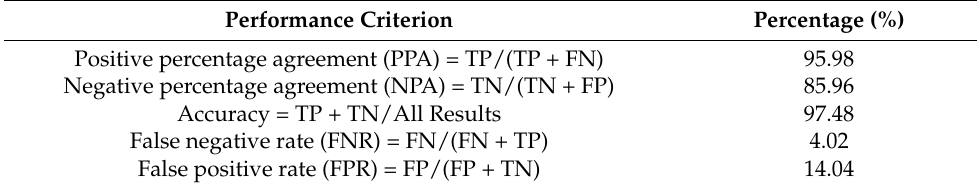
Table 2. Performance metric evaluation of the respiratory viral panel.